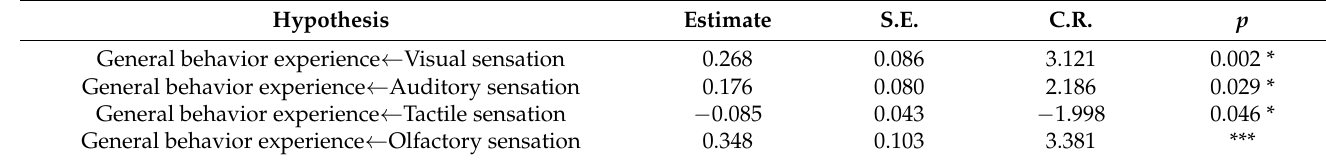
Table 5. Results of path analysis: standardized estimates ( n =